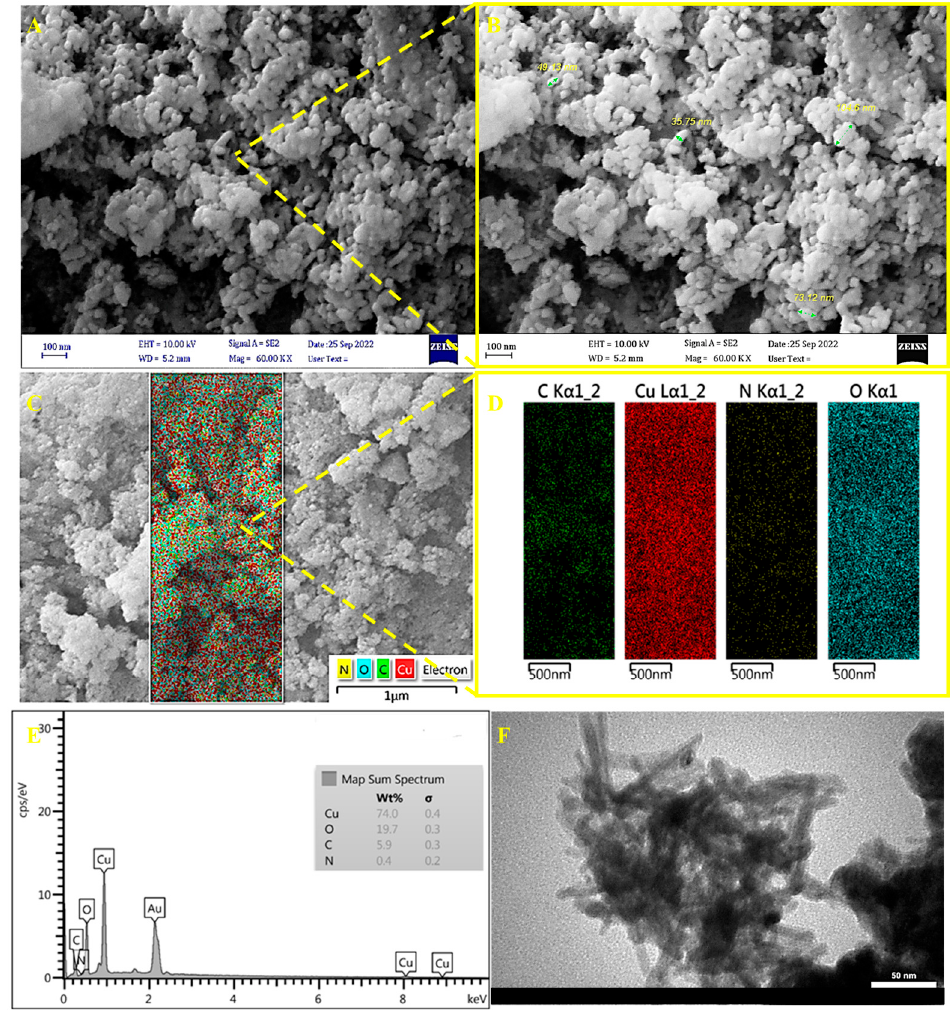
Figure 1. ( A , B ) SEM images, ( C – E ) EDX analysis and elemental mapping, and ( F ) TEM image of the synthesized Cu-Guo NRs.